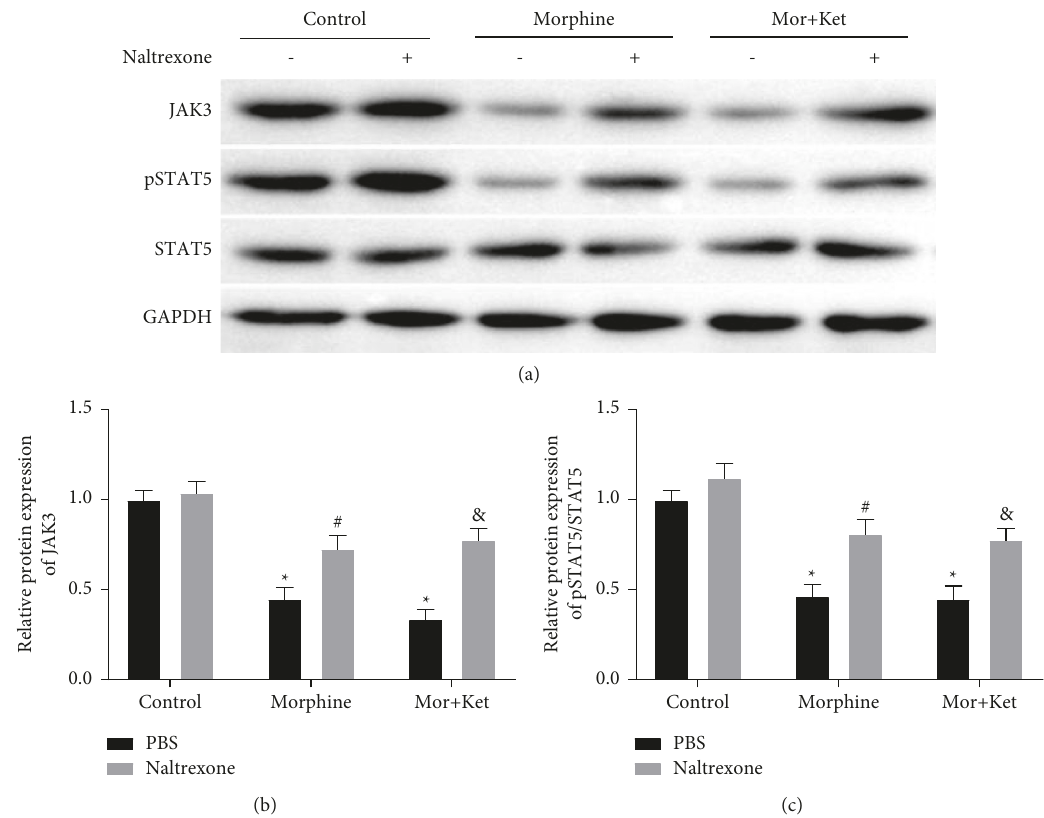
Figure 5: Naltrexone reverses the suppressive effects of morphine and ketamine on the JAK3/STAT5 pathway in vitro. (a) The Western blot assay images for the levels of JAK3, pSTAT5, and STAT5 in Tcells. (b) The protein level of JAK3 in Tcells measured by Western blot assay. (c) The protein level of pSTAT5/STAT5 in Tcells measured by Western blot assay. ∗ P < 0 . 05 vs. the control (PBS) group. # P < 0 . 05 vs. the morphine (PBS) group. & P < 0 . 05 vs. the Mor +Ket (PBS)